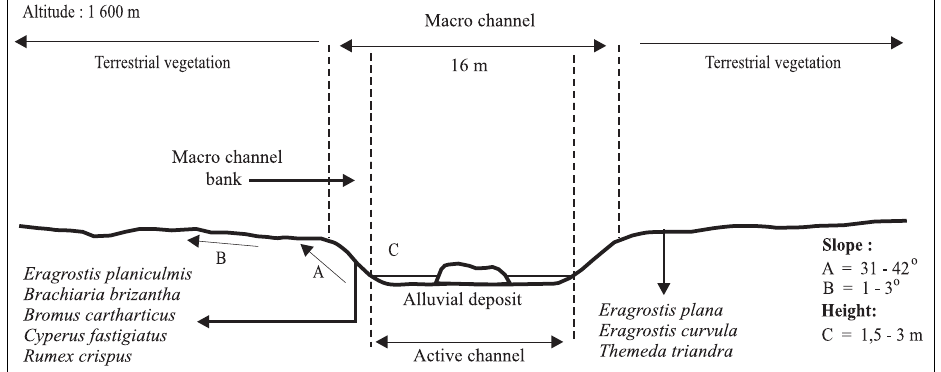
Fig. 6. River profile of the Eragrostis plana-Cyperus fastigiatus grassland.